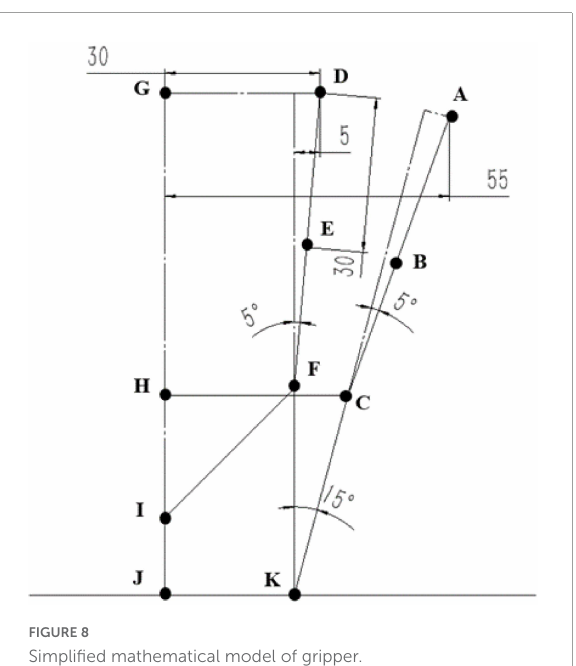
FIGURE8 Simplified mathematical model of